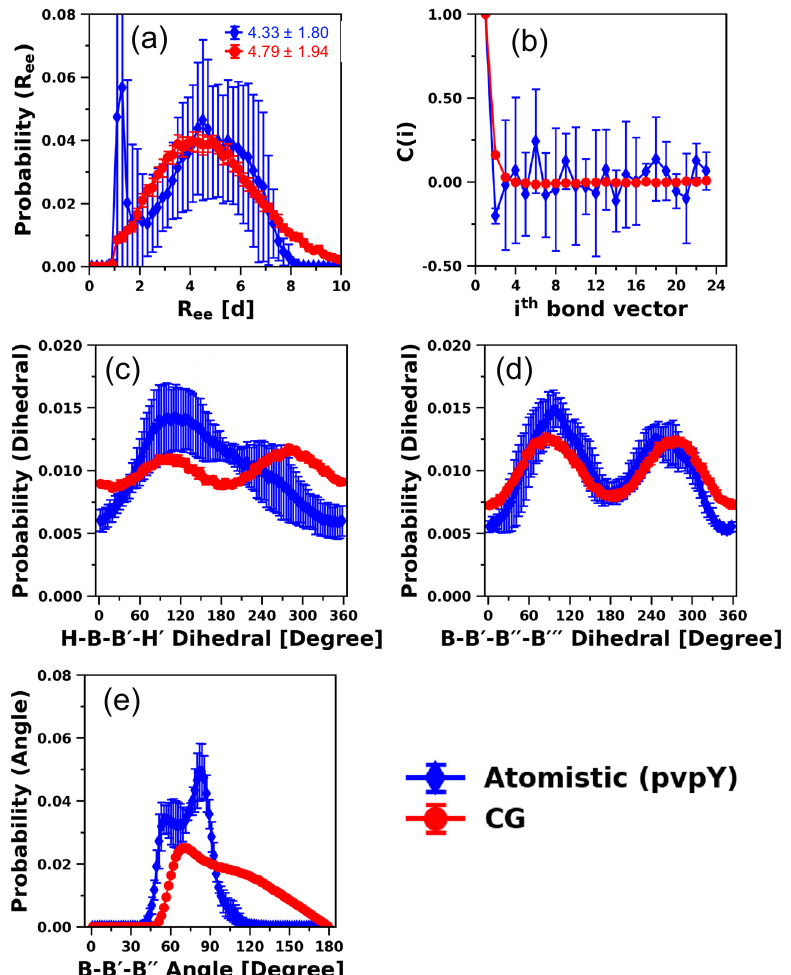
Figure 5. Comparison of distributions of ( a ) R ee distance (with ensemble average values in reduced units (d)), ( b ) bond-vector autocorrelation functions, ( c ) H-B-B (cid:48) -H (cid:48) dihedral, ( d ) B-B (cid:48) -B (cid:48)(cid:48) -B (cid:48)(cid:48)(cid:48) dihedral, and ( e ) B-B (cid:48) -B (cid:48)(cid:48) angle, for 24-mer pvpY chains, obtained from atomistic simulations and CG simulations (for the best performing case of attractive interaction between any two backbone beads (B-B), ε BB , in the CG model equal to 0.7 kT and B-B (cid:48) -B (cid:48)(cid:48) -B (cid:48)(cid:48)(cid:48) and H-B-B (cid:48) -H (cid:48) torsional constraints simultaneously imposed). The standard deviations are computed from the means of 5 independent trials for atomistic simulations and 10 independent trials for CG simulations and the lines joining the symbols in parts ( a , c – e ) are drawn to guide the